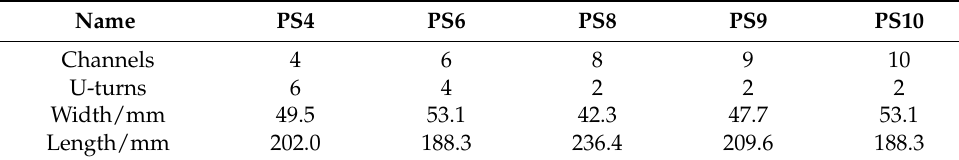
Table 5. Parallel serpentine configurations for a geometric area of 100cm 2 and channel width of 0.9mm.